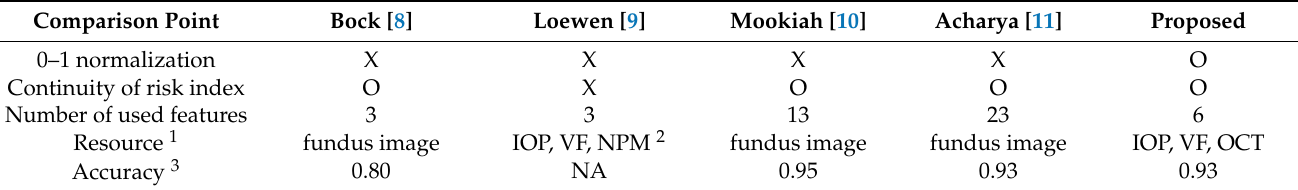
Table 11. Comparison of state-of-the-art work and the proposed method.